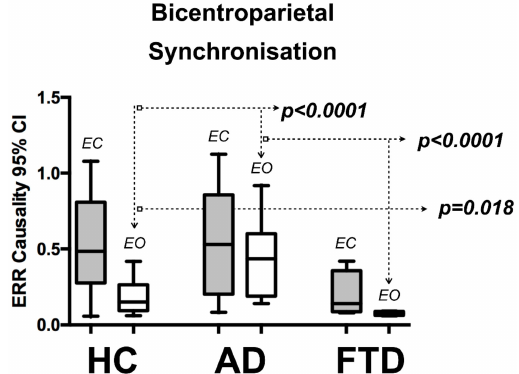
Figure 3. QEEG bi-centroparietal synchronization, group comparison between AD, HC & FTD. This graph depicts the median with 95% CI bi-centroparietal (C3–P3 to C4–P4) synchronization for Eyes Closed (EC) and Eyes Open (EO) states from HC-Healthy Controls ( n = 20) and AD-Alzheimer’s disease ( n = 20) & FTD–frontotemporal dementia ( n = 4). The non-parametric Mann Whitney test of group differences was